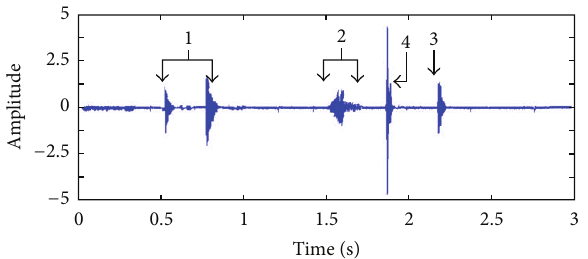
Figure 9: Typical acoustic emission signal with cracking.